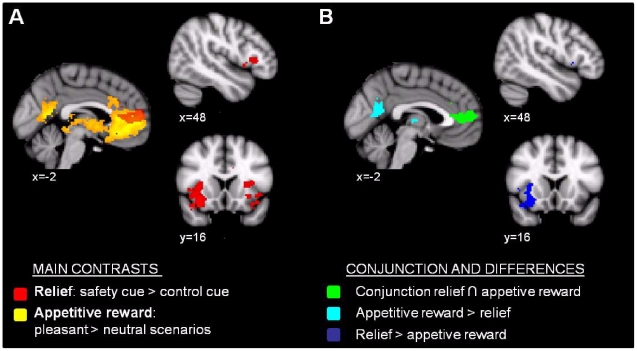
Task-induced brain activation patterns.A: Main effect of relief task (red) and appetitive reward task (yellow). B: The overlap between the two tasks (green) and between-tasks contrasts (light and dark blue). MRI images are overlaid on the normalised average of the whole group's structural scans, and thresholded using a cluster-based approach with Z>2.3, p<0.05, corrected for multiple comparisons.